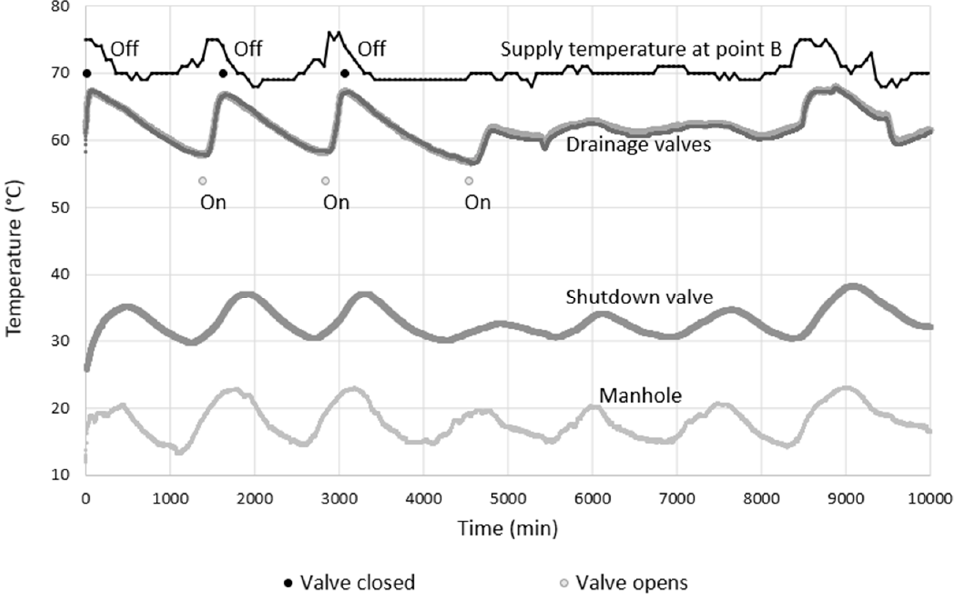
Figure 11. Temperature measurements during the three shutdowns (i.e., off to on) followed by normal operation starting at approximately 4500 min.